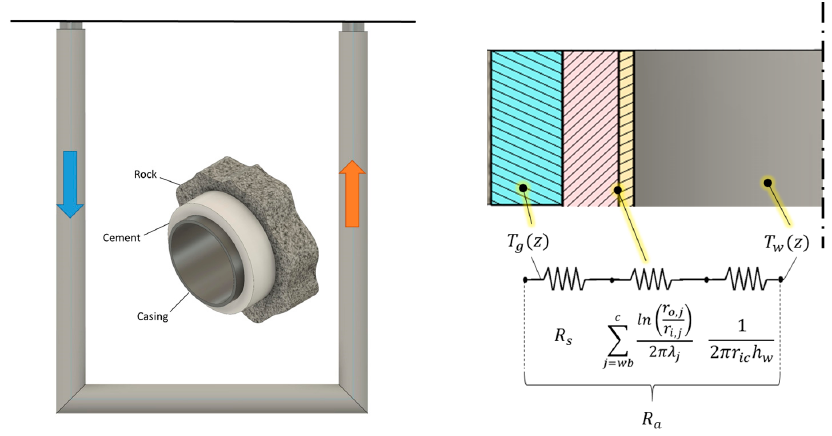
Figure 2. Thermal resistances and cross-section of the ULHE.